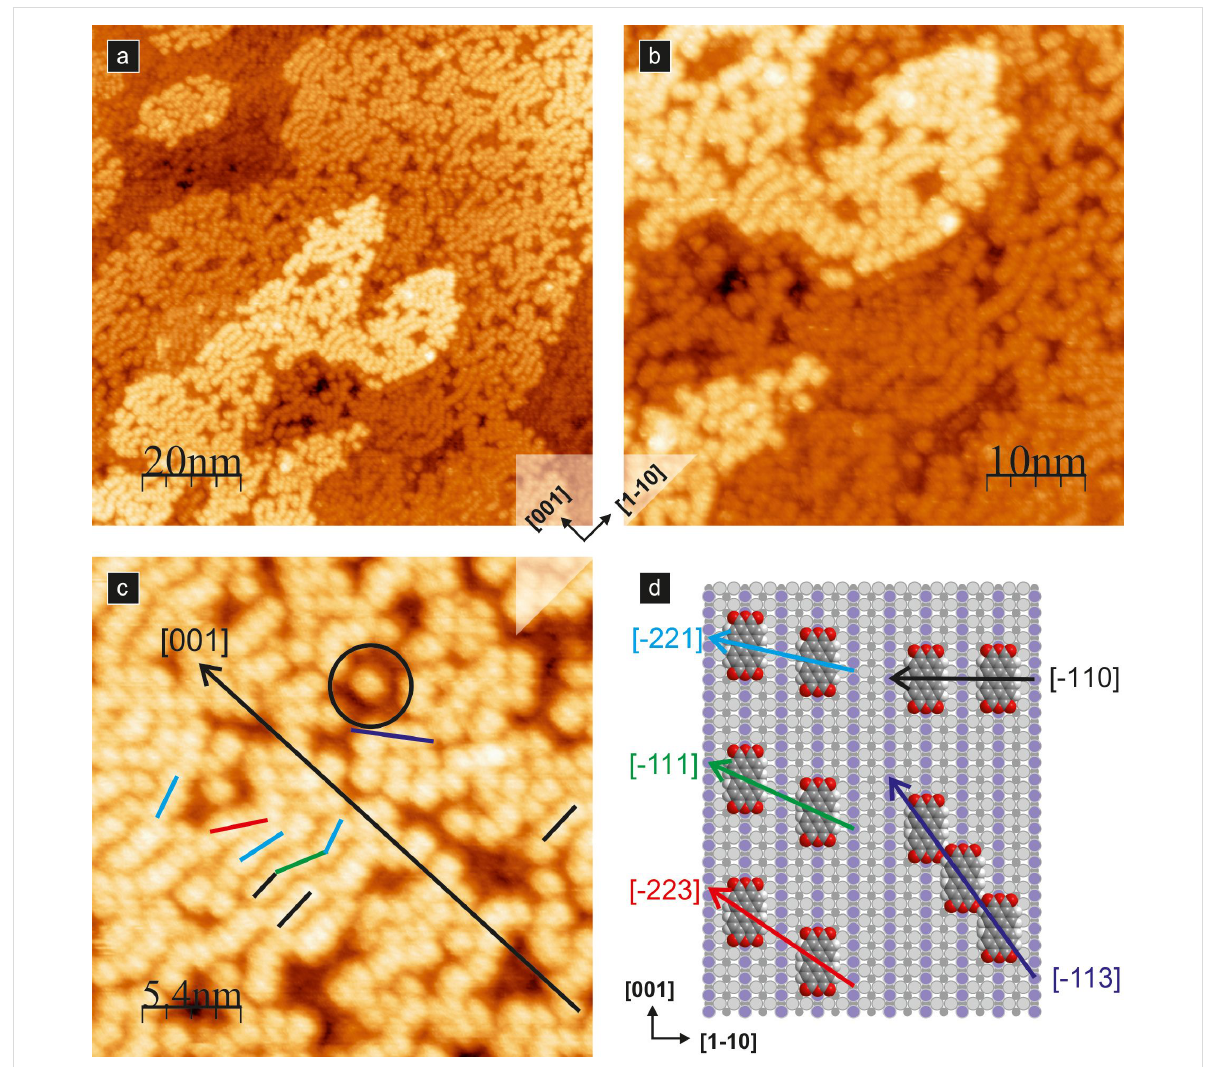
Figure 3: 0.7 ML of PTCDA molecules on a TiO 2 (110) surface; (a), (b) and (c) are empty state STM images showing meandering molecular lines, and (d) shows the structural model of molecular lines. Coloured arrows (panel (d)) and lines (panel (c)) indicate different orientations of neighbouring molecules, and a circle indicates a single molecule STM image containing two